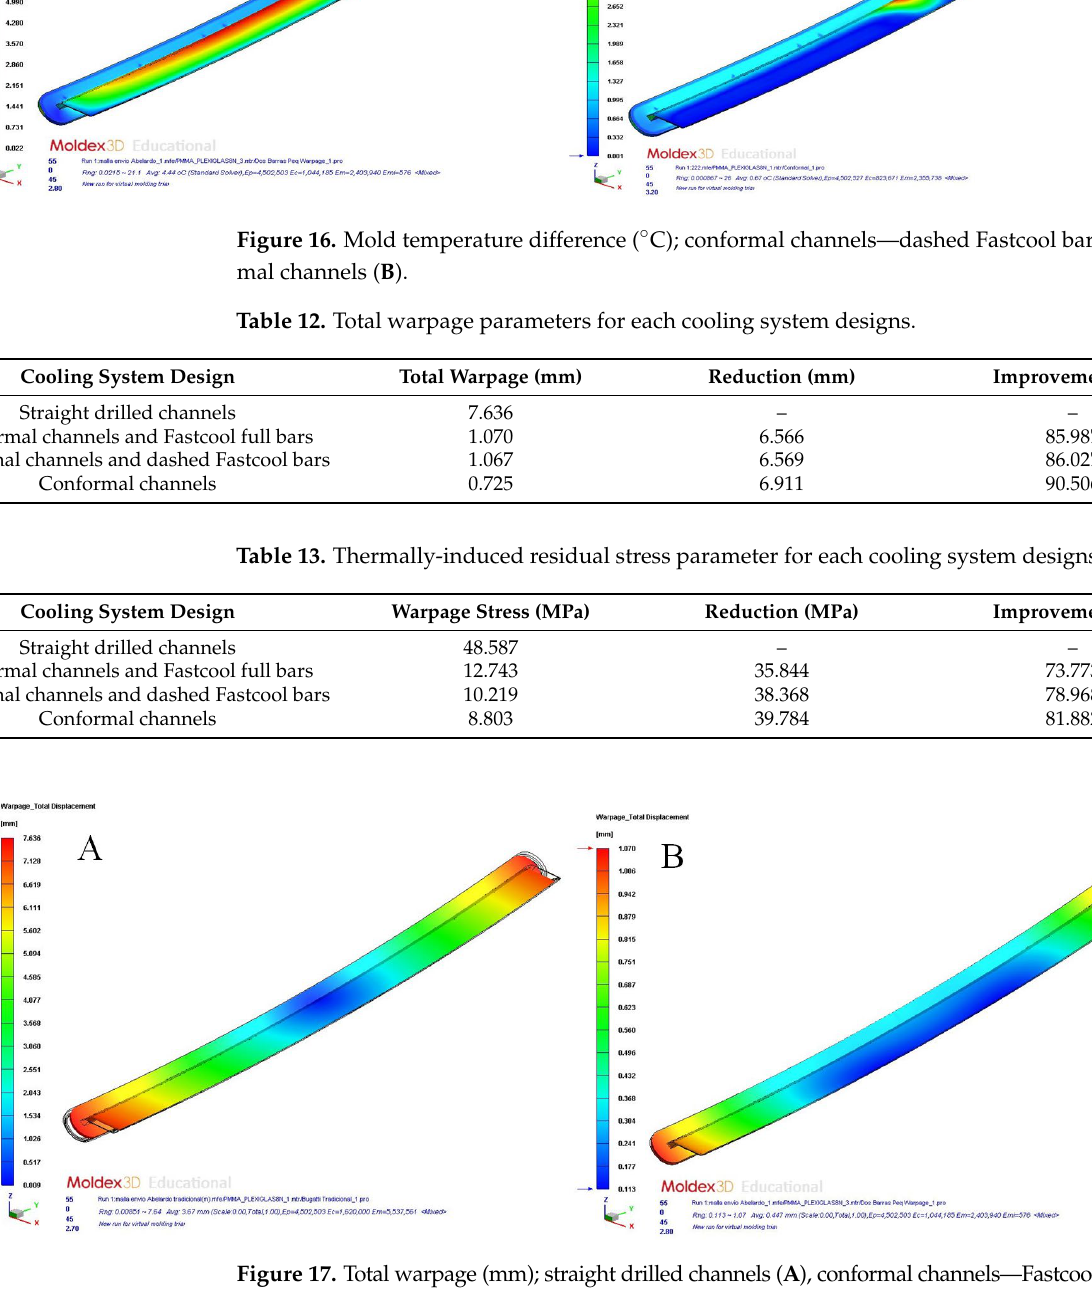
Figure 18. Total warpage (mm); conformal channels—dashed Fastcool bars ( A ), conformal channels ( B ).